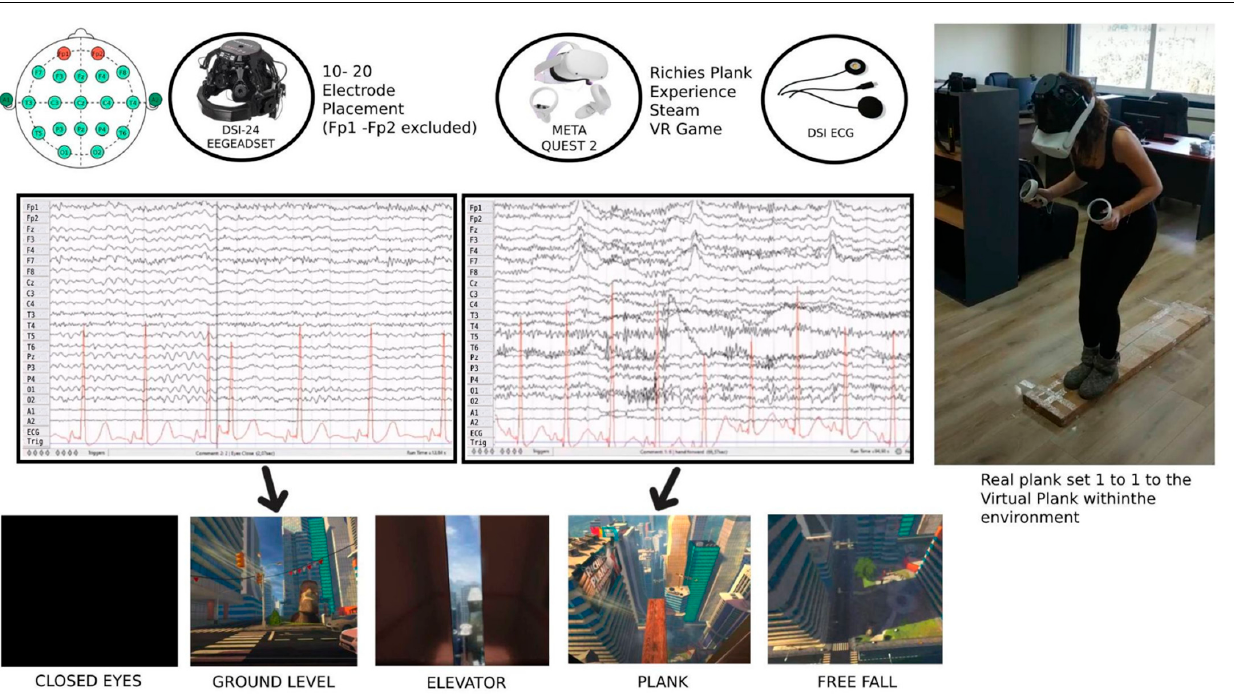
Figure 3. Experimental design.